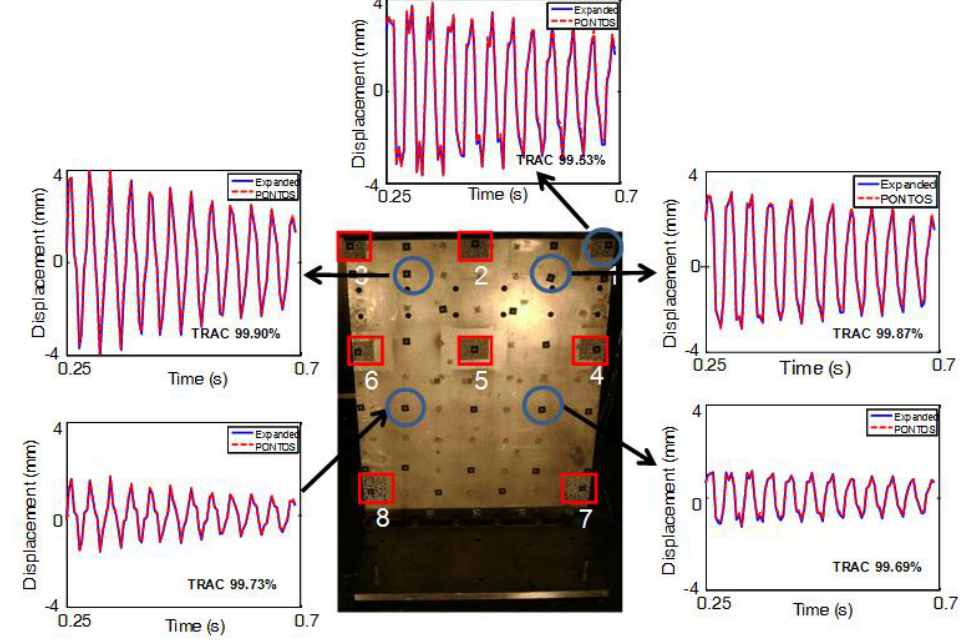
Fig. 12. Overlay of the displacement responses from predicted solution using first five modes for expansion and PONTOS at five different locations; expansion performed using sensor configuration